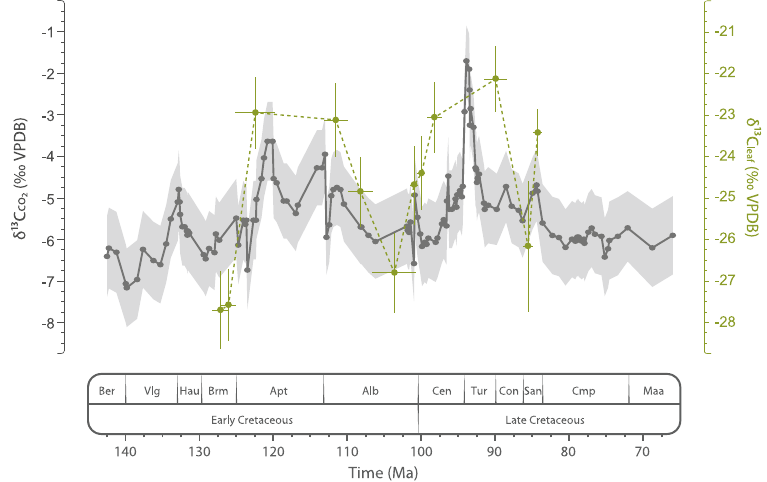
Figure 1. Comparison of the carbon isotope compositions of leaves of the fossil conifer Frenelopsis ( δ 13 C leaf ) obtained for each studied episode with the evolution of the carbon isotope composition of atmospheric CO 2 ( δ 13 C CO2 ) throughout the Cretaceous estimated by Barral et al . 16 . Envelopes and bar errors correspond to ± 1 σ